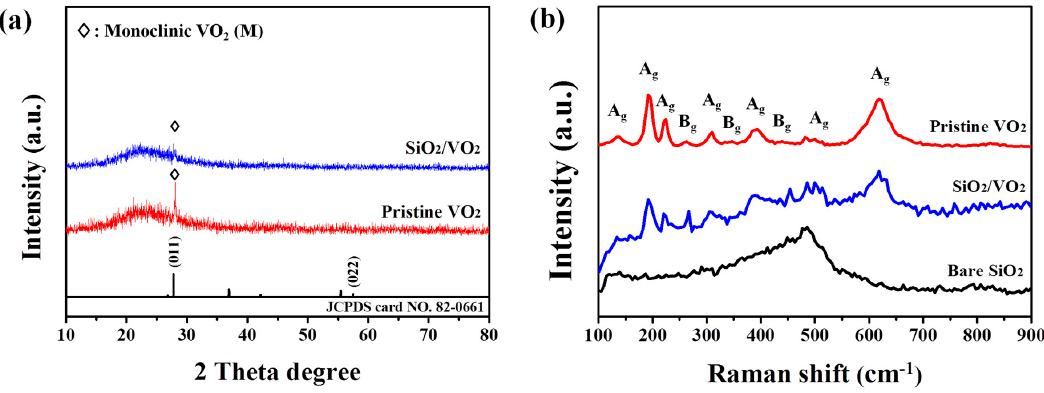
Figure 2. X-ray diffraction (XRD) ( a ) and Raman spectra ( b ) of VO 2 and SiO 2 /VO 2 thin films.